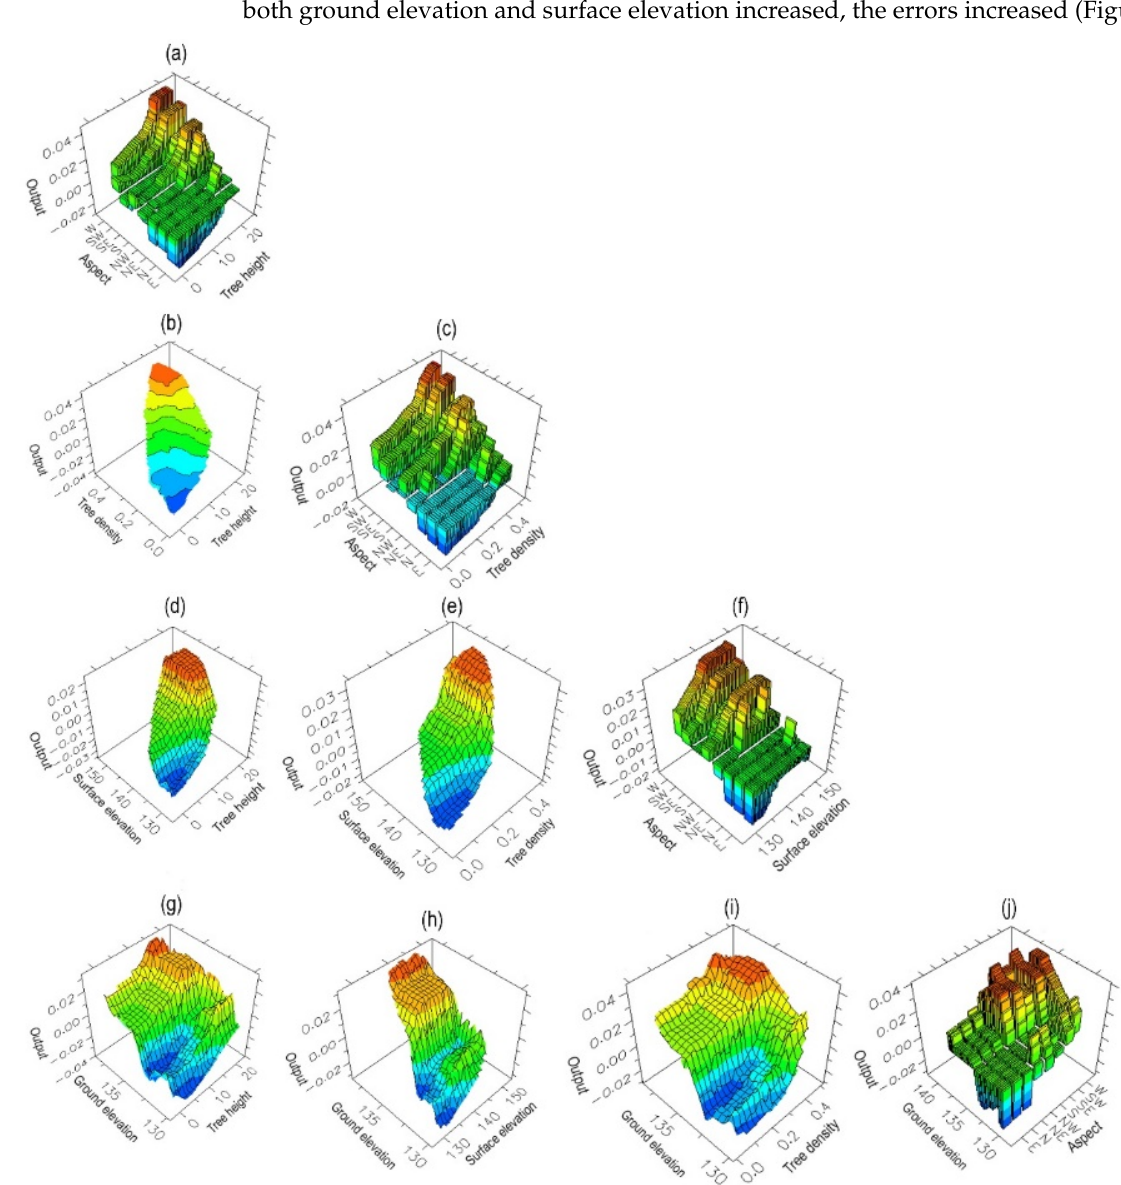
Figure 8. Bivariate partial dependence plots for five top features affecting the positioning accuracy of the u-blox ZED-F9P. ( a ) tree height and aspect, ( b ) tree height and tree density, ( c ) tree density and aspect, ( d ) tree height and surface elevation, ( e ) tree density and surface elevation, ( f ) surface elevation and aspect, ( g ) tree height and ground elevation, ( h ) surface elevation and ground elevation, ( i ) tree density and ground elevation, and ( j ) aspect and ground elevation.